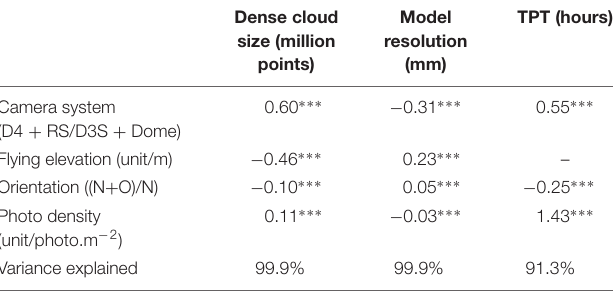
TABLE 4 | Effects of the acquisition parameters on the model statistics.